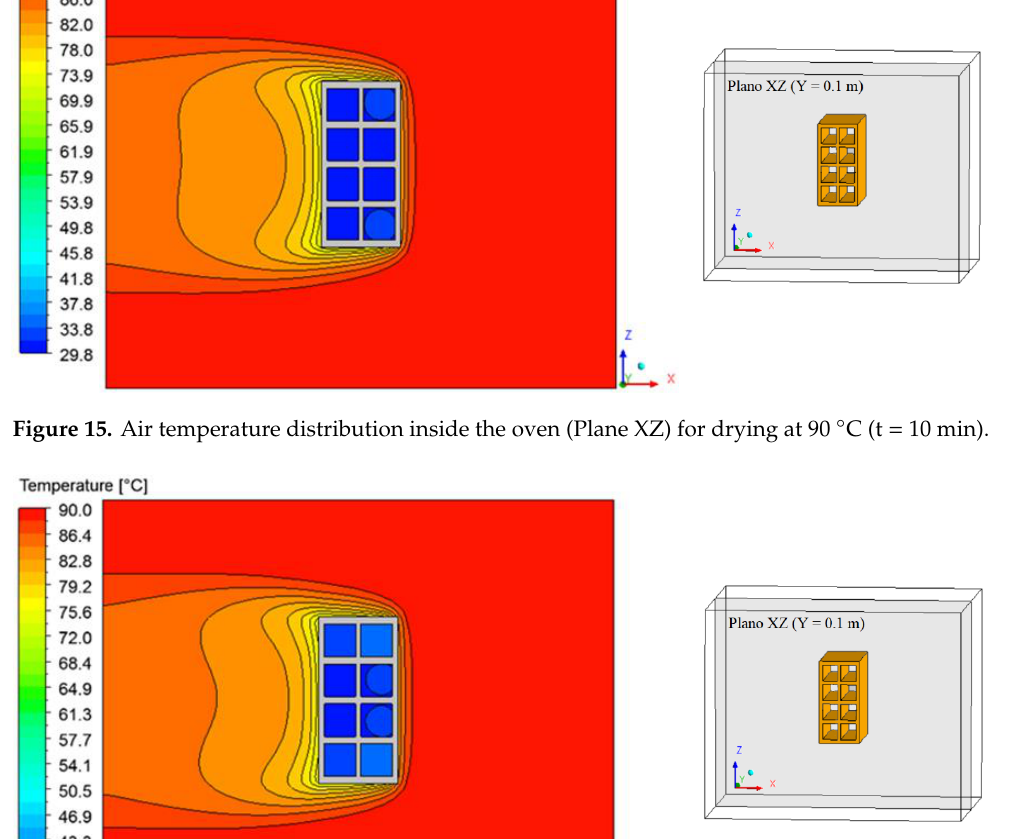
Figure 17. Air temperature distribution inside the oven (Plane XZ) for drying at 90 °C (t = 690 min). For each instant of time, the results of the numerical simulation provide the values of the convective heat transfer coefficients. Performing an arithmetic mean of the results, the values of this parameter for each drying temperature are reported in Table 4. Table 4. Convective heat transfer coefficient obtained with the simulations. Temperature [°C] h c [W/(m².K)] 50